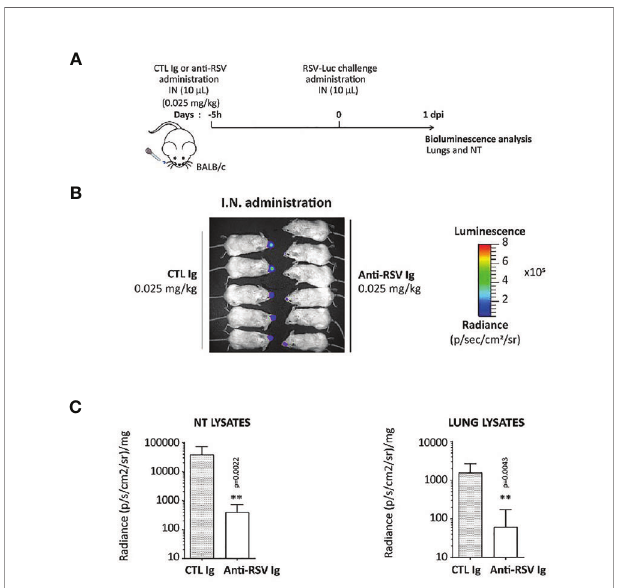
FIGURE 6 | Preventive effect of anti-RSV Ig intranasal administration on upper respiratory tract RSV infection in mice. (A) BALB/c mice received I.N. administration of 0.025 mg/kg of anti-RSV Ig in 10 µL fi ve hours before I.N. injection of RSV-luciferase (1.4 x 10 5 pfu, 10 µL). As a control of infection, mice were treated with CTL Ig. (B) In vivo bioluminescence intensity was evaluated at 1 d.p.i. with IVIS imaging system (dorsal view detection). (C) Luciferase activity was measured in NT and lung homogenates by quanti fi cation of bioluminescence emission (radiance in photon/sec/cm 2 /sr) using “ Living Image ” software after addition of luciferin in the wells, and was normalized to the organ weight. Data are mean ± SEM from n = 6 mice for CTL Ig-treated mice and n = 5 for mice treated with 0.025 mg/kg of anti-RSV Ig. Signi fi cance is represented on graphs: **P <